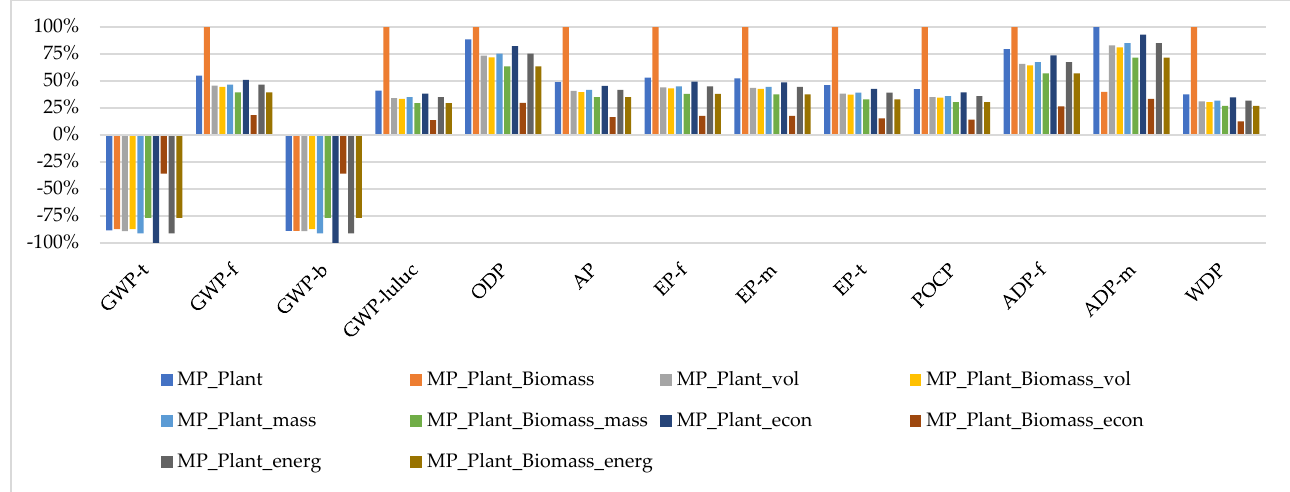
Figure 3. Relative environmental impacts of biomass and roundwood from MP_Plant scenario.